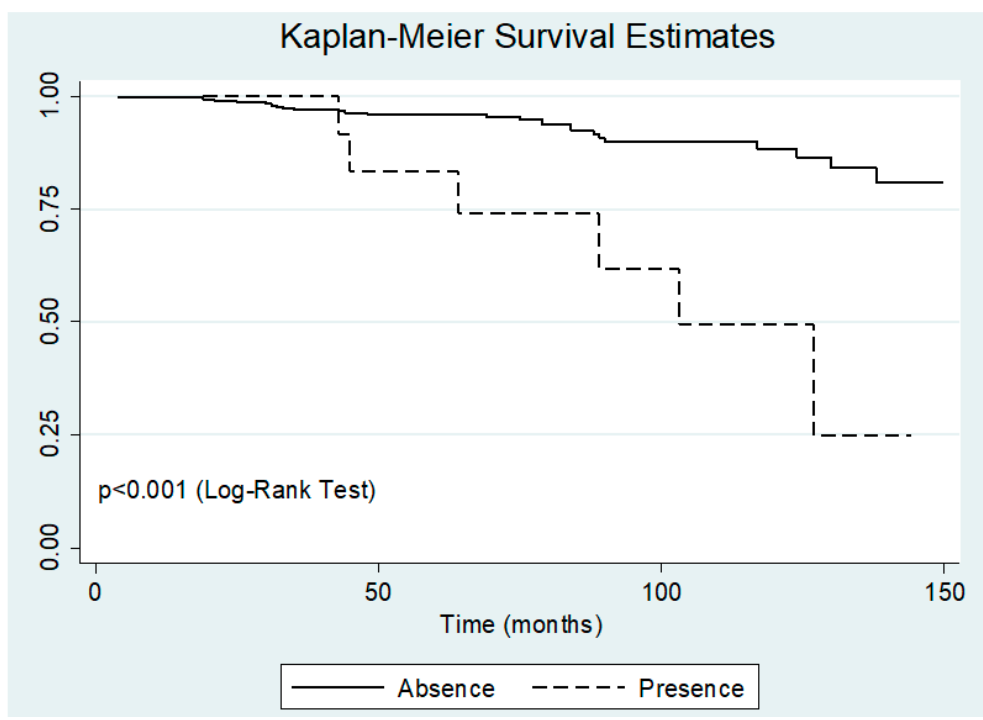
Figure 1. Kaplan–Meier survival curve stratified by the presence of non-chagasic cardiomyopathy.